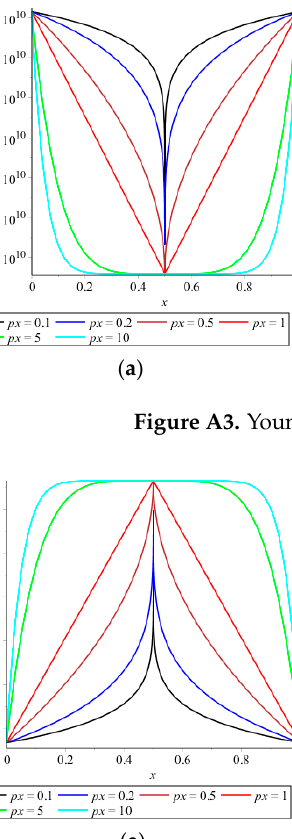
Figure A2. Density evolution [kg.m − 3 ] of ( a ) FGM1-Z; ( b ) FGM2-Z. The symmetrical mixture evolution along the beam length as jointly defined by Equa- tions (2)–(4), is depicted for the Young’s modulus distribution in Figure A3 and for the density in Figure A4.